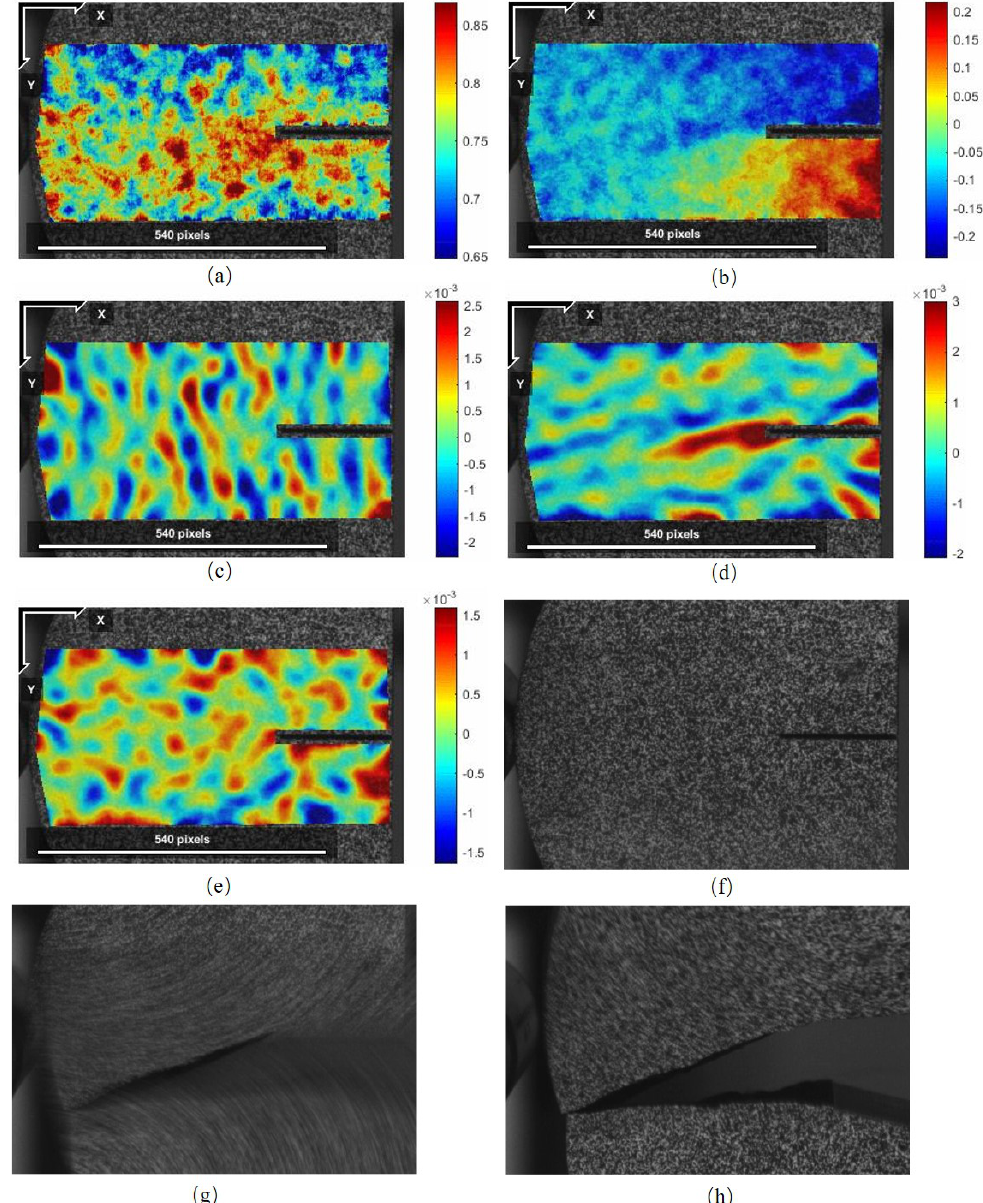
Figure 16. Displacement field, strain field, and photos of specimen D2 before and after the fracture: ( a ) distribution field of vertical displacement U before the occurrence of the D2 fracture; ( b ) distri- bution field of horizontal displacement V before the occurrence of the D2 fracture; ( c ) distribution field of strain ε x before the occurrence of the D2 fracture; ( d ) distribution field of strain ε y before the occurrence of the D2 fracture; ( e ) distribution field of strain ε xy before the occurrence of the D2 frac- ture; ( f ) photo before the occurrence of the D2 fracture (the original 3057th photo); ( g ) photo during the occurrence of the D2 fracture (the original 3058th photo); ( h ) photo after the D2 fracture (the original 3059th photo).